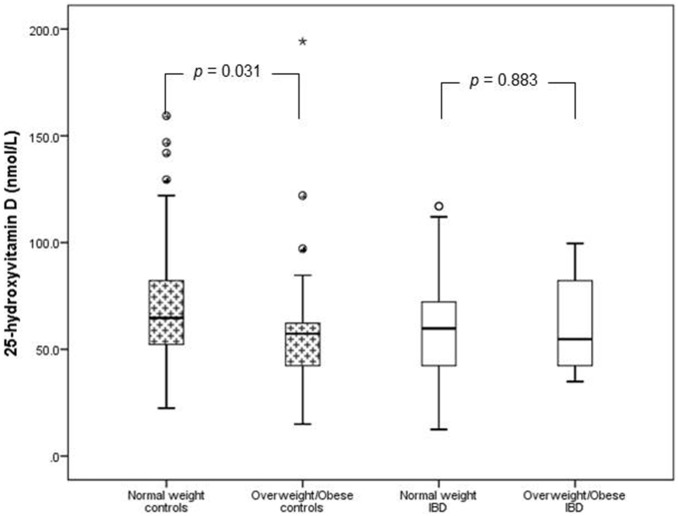
Box plots of the comparison of 25-hydroxyvitamin D concentration of patients with inflammatory bowel disease (IBD) and normal controls stratified by body mass index.This figure shows that the overweight/obese controls had significantly lower value for 25(OH)D than the normal weight controls (58.32±27.63 vs. 69.76±27.45, p = 0.031), while there was no significant difference in 25(OH)D value between the normal weight and overweight/obese IBD patients (59.71±26.44 vs. 60.91±23.26, p = 0.883). Note: 50 nmol/L = 20 ng/mL.